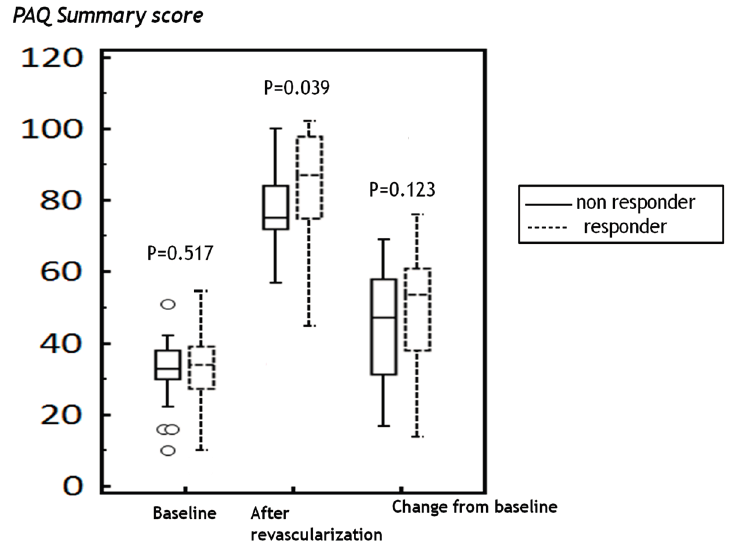
Figure 2. After revascularization, peripheral artery questionnaire summary scores were higher in the responder group; however, the scores from the baseline were not significantly different between the